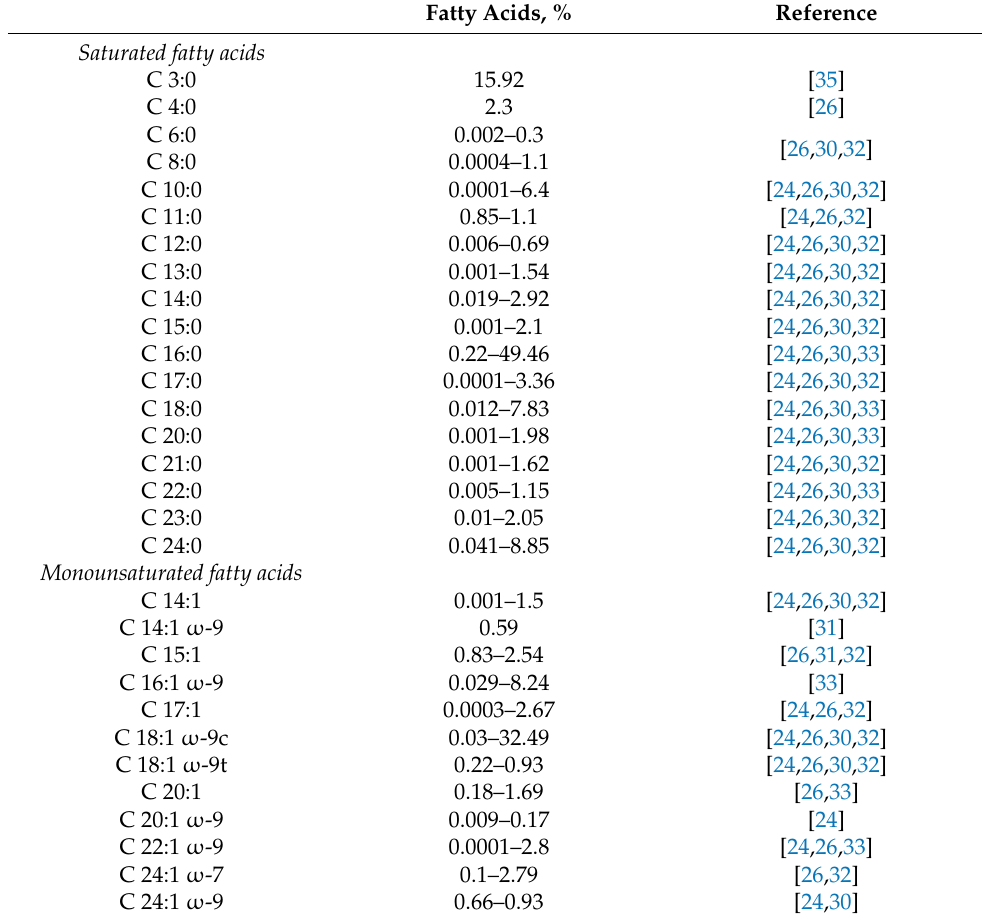
Table 5. Fatty acids composition in C. lentillifera